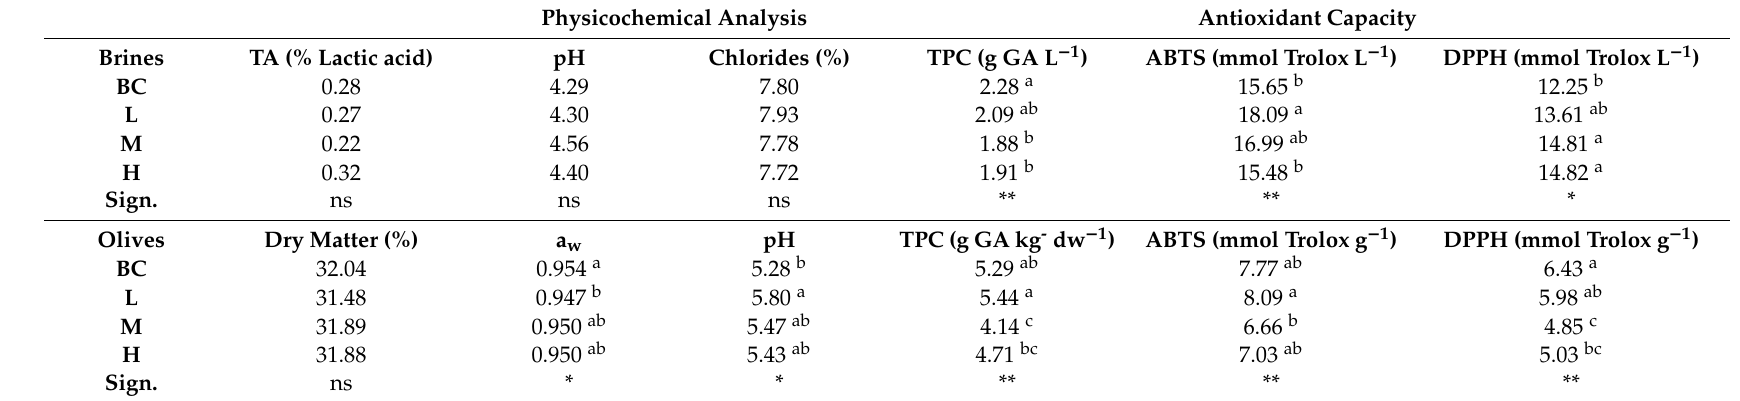
Table 4. Physicochemical and antioxidant characterization of brine and olives after 6 months of fermentation. Physicochemical